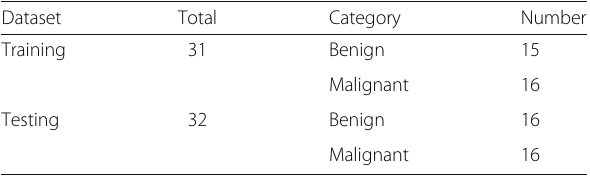
Table 3 The training samples and testing samples for polyp classification